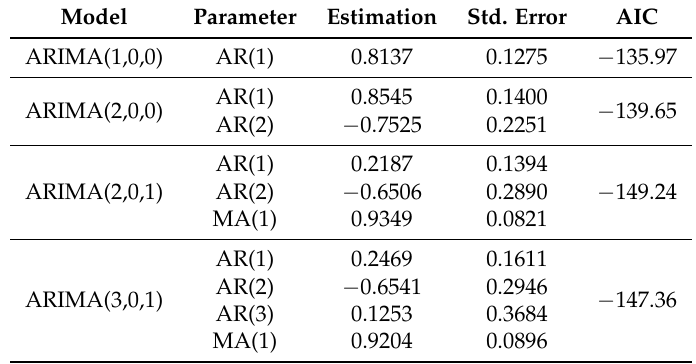
Table 2. Estimations of candidate models. AIC: Akaike’s information criterion; ARIMA: autoregressive integrated moving